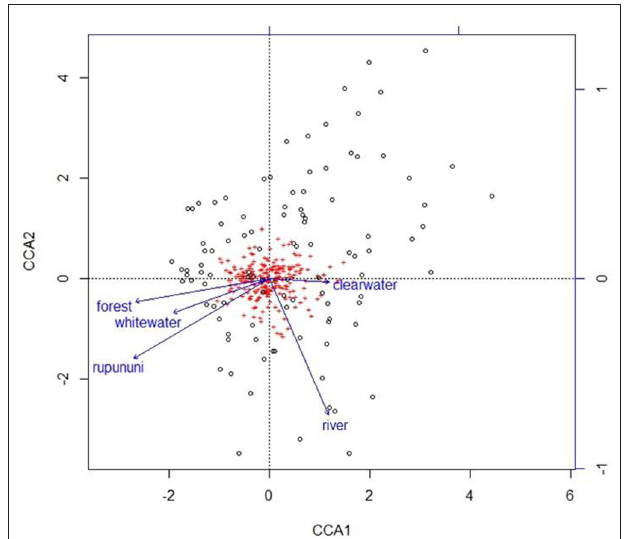
FIGURE 4 | Plot from canonical correspondence analysis (CCA) scores on axis 1 and axis 2 based on the matrix of species assemblages and matrix of habitat variables. Red plus signs represent species and location on the plot indicates distributional similarity. Open circles represent sites and location on plot indicates compositional similarity. TABLE 4 | Monte Carlo permutation tests on all variables, by axes, and by variable (significant codes: 0 “***,” 0.001 “**,” 0.01 “*”).